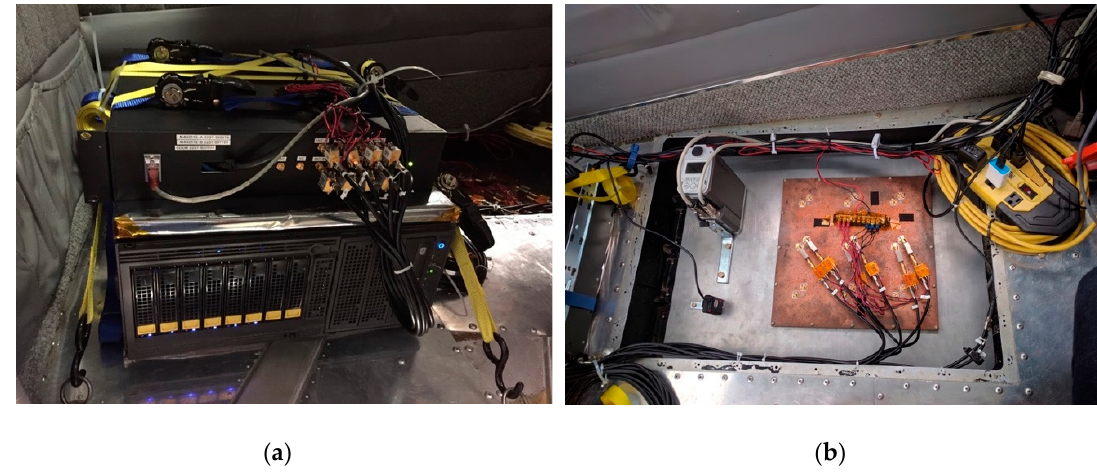
Figure 2. ( a ): Sampler and front-end electronics (top) with 8 antenna inputs and low-noise amplifiers (LNAs), and solid state disk (SSD) array (bottom) with 8 TB of storage. ( b ): View of 9-element patch antenna from inside the aircraft, with central three patches’ H and V-Pol outputs cabled. IR camera is on upper left of antenna, and optical camera is small black box on lower left of antenna.